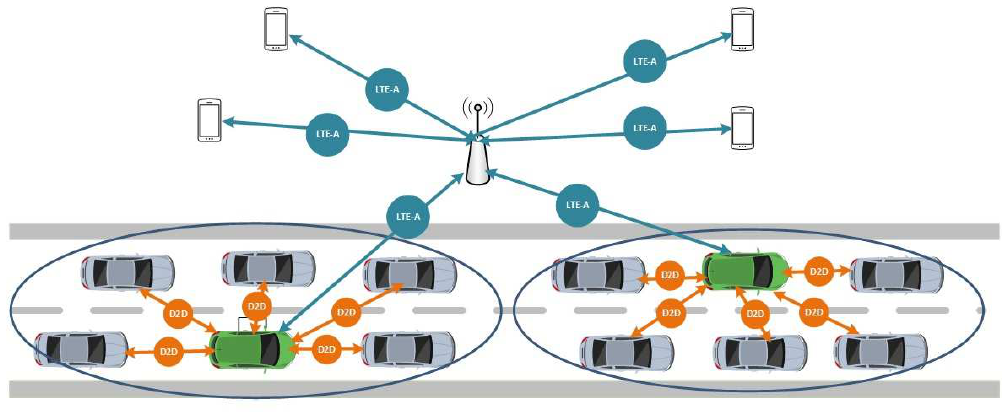
Figure 1. Overview of the